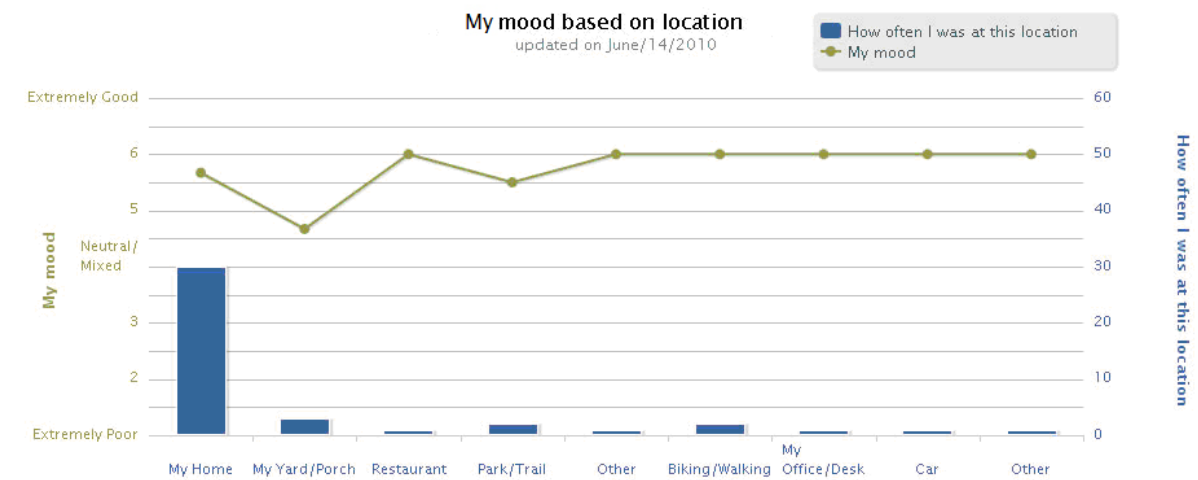
Figure 4. Graphical feedback available to users on the website (blue bars denote locations that a participant reported on the mobile phone, and the frequency with which each location was reported; the green line denotes the participant’s average reported mood in each